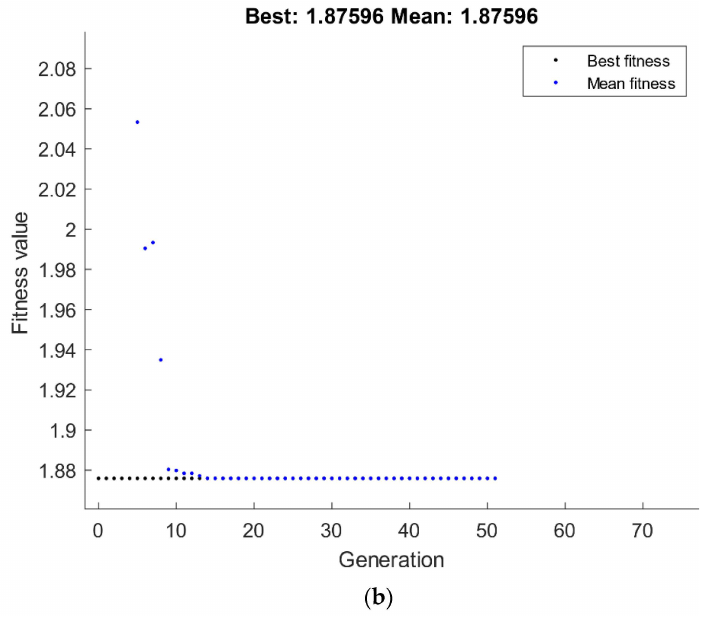
Figure 12. Optimum grain size by GA ( a ) and hybrid RSM-GA ( b ).